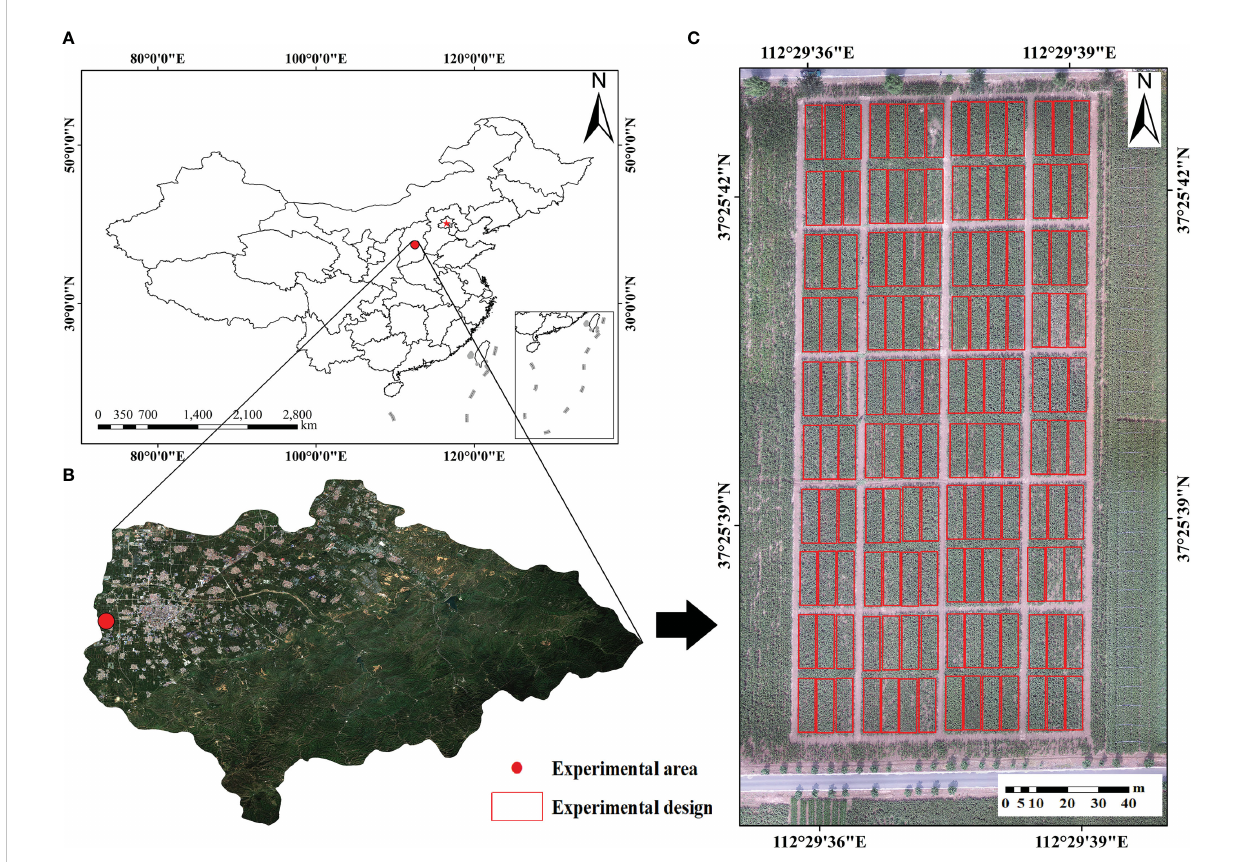
FIGURE 1 Overview of the study area. (A) Geographical location of Taigu District (B) the location of the experiential area (C) the design of the fi eld